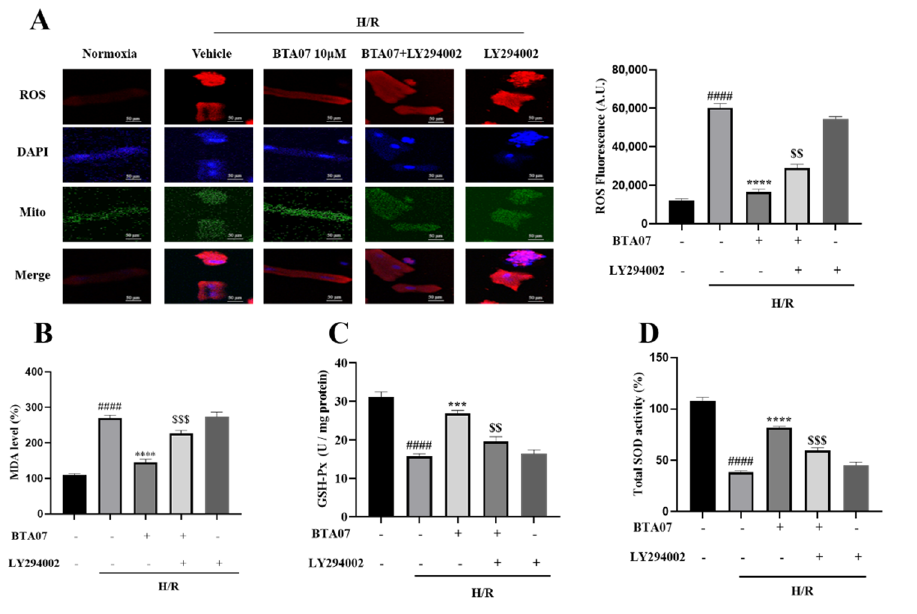
Figure 7. Pharmacological inhibition of PI3K with LY294002 abolished BTA07-induced antioxida- tive potential in ARCMs. ( A ) Representative images of a fluorescence probe for ROS in ARCMs. The concentration of ROS dye was 5 μ M. Levels of malondialdehyde (MDA, B ), glutathione peroxidase (GSH-Px, C ) and superoxide dismutase (SOD, D ) in the ARCM lysates were detected. Data are presented as means ± S.E.M for three independent experiments. #### p < 0.0001 vs. normoxia group; **** p < 0.0001 vs. vehicle group; *** p < 0.001 vs. vehicle group; $$$ p < 0.001 vs. BTA07 group; one − way ANOVA test, followed by a Student–Newman–Keuls test.